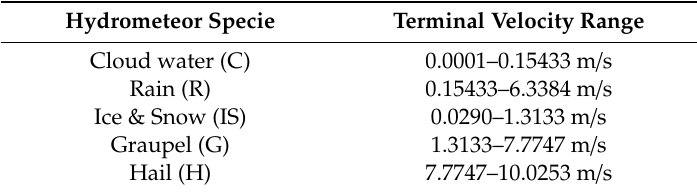
Table 2. Terminal velocity range of hydrometeor species classified by